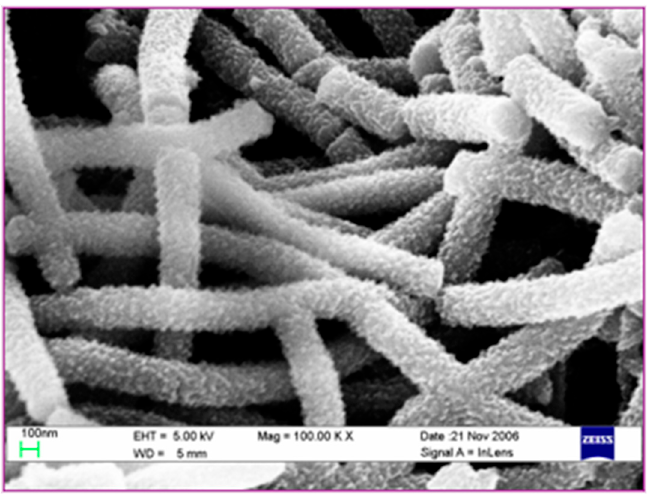
Figure 14. SEM images showing the surface morphology of electrospun polyaniline nanofibers.